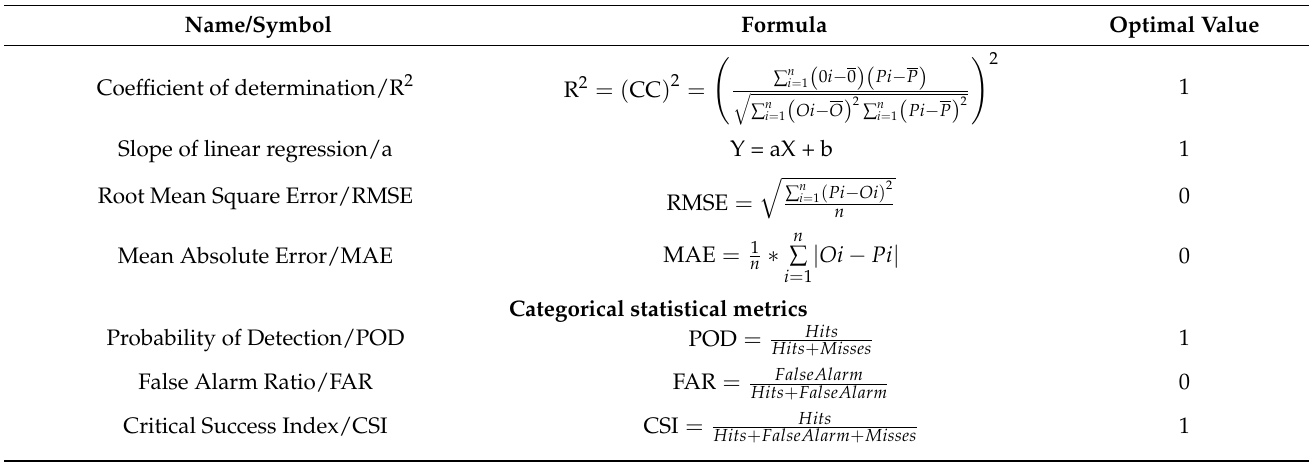
Table 2. Statistical metrics used to quantify GPP